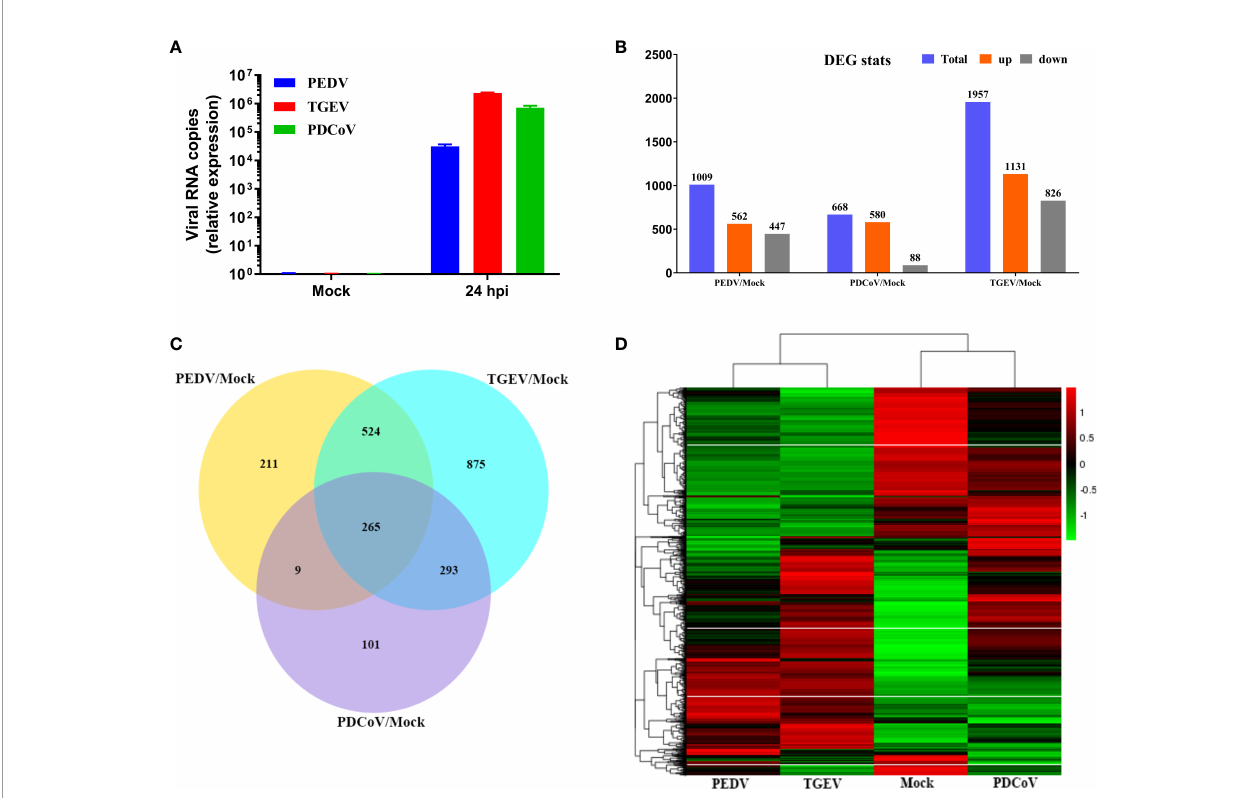
FIGURE 2 | Unique and overlapping transcriptional pro fi les in porcine enteroids following different SECoVs infection. (A) Con fi rmation of SECoVs infection in jejunal enteroids by RT-qPCR. Jejunal enteroid monolayers were respectively infected with PEDV (MOI = 5), TGEV (MOI = 1), or PDCoV (MOI = 2) for 24 h, and collected for quantifying the viral genomes of SECoVs. Each data bar represents the means ± SEMs (n = 3). (B) The statistical graph results of differential expressed genes of jejunal enteroids after infection with PEDV, TGEV, or PDCoV. Jejunal enteroid monolayers isolated from three individual SPF 2-day-old piglets were mock-infected or infected with PEDV (MOI = 5), TGEV (MOI = 1), or PDCoV (MOI = 2) for 24 h. Then, the total RNA isolated from enteroids was used for RNA-Seq. (C) Venn diagram of common differentially expressed genes of jejunal enteroids elicited by PEDV, TGEV, or PDCoV. (D) Heat map of differentially expressed genes in jejunal enteroids infected with PEDV, TGEV, or PDCoV. Data are based on log(RPKM) values (n =